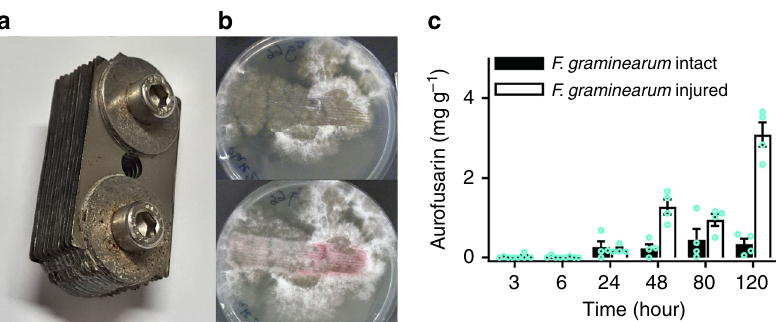
Fig. 6 Mechanical injury induces aurofusarin synthesis. a An array of 10 razor blades assembled at distances of 1 mm. b Fusarium graminearum IFA66 on GM7 medium at 22 °C immediately after injury with the razor blade array (upper photo) and 24 h later (lower photo). c F. graminearum cultures were grown on rice media for 5 days, injured with the blade array in the same manner as in b , and harvested at the indicated times. The aurofusarin content was determined via HPLC-MS/MS ( n = 4, error bars show s.e.m). Source data are provided in a Source Data fi